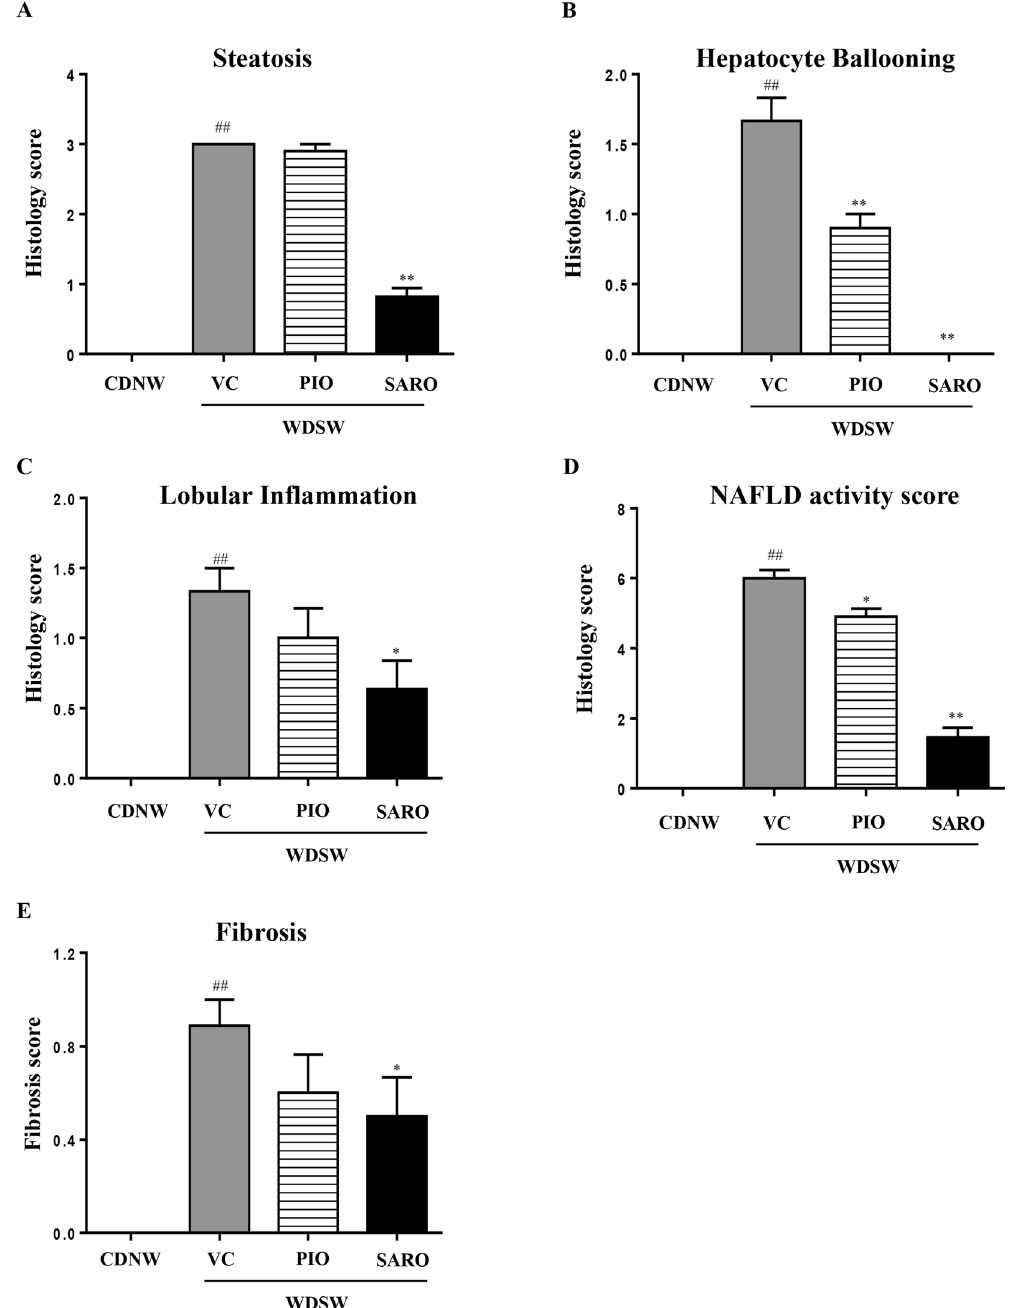
Figure 4. Saroglitazar treatment ameliorates fatty liver, steatohepatitis and fibrosis. DIAMOND mice were treated with pioglitazone, saroglitazar or vehicle control for 12 weeks along with CDNW or WDSW. Mice were maintained on this diet for 12 weeks prior to the initiation of treatment to develop fatty liver and steatohepatitis. Histology score for ( A ) steatosis, ( B ) hepatocyte ballooning, ( C ) lobular inflammation, ( D ) NAFLD activity score and ( E ) fibrosis were quantified. Data are expressed as the mean ± SEM for 6–12 mice per group. ## p < 0.001 compared to CDNW; * p < 0.05, ** p < 0.001 compared to WDSW, vehicle